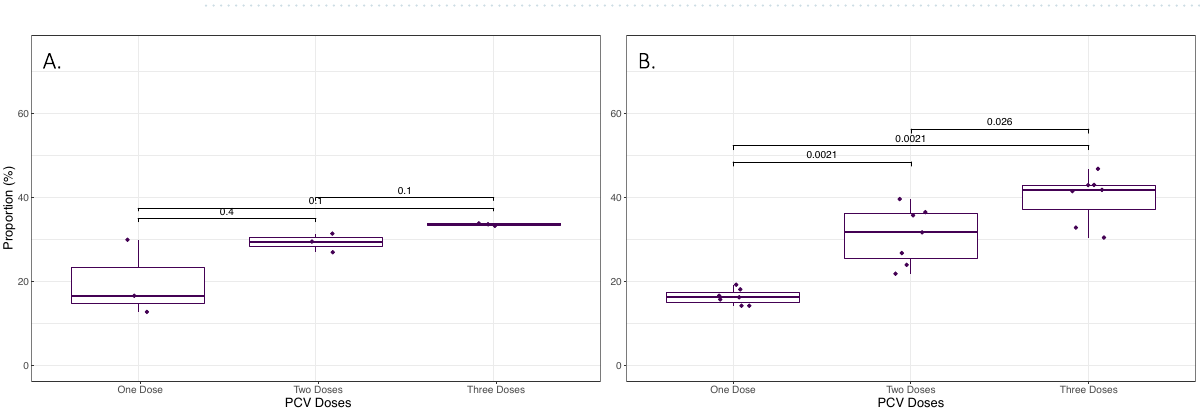
Figure 7. Isolation of PCV-type serotypes following PCV13 introduction in 2010. Serotypes 5, 6B, 6A have not been isolated since 2012/13. In recent years, 19A and 3 have been the most frequently isolated PCV serotypes (n = 7 and n = 5 respectively).